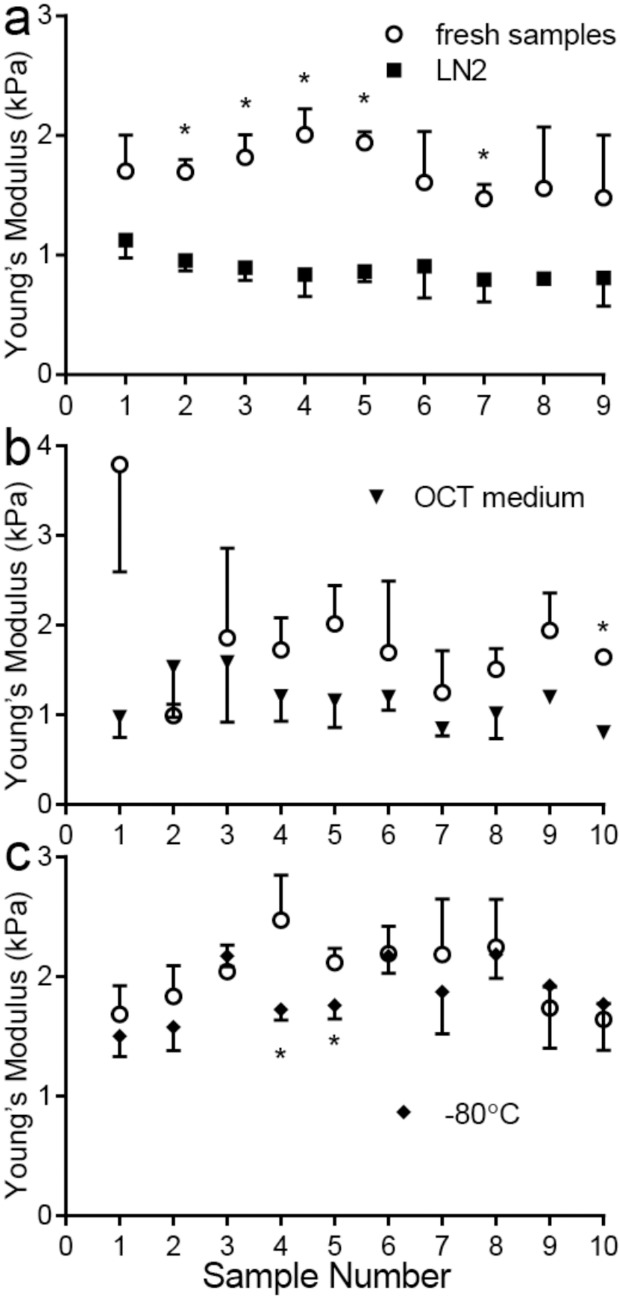
Mechanical properties of fresh vs. frozen tissue using micro-indentation.Fresh lung samples were tested using micro-indentation and then frozen using either (a) Liquid Nitrogen (LN2), (b) OCT medium with LN2, or (c) slowly frozen to -80°C, and subsequently re-tested. Samples marked with * are statistically significantly different after freezing, compared to the original fresh tissue specimen, (p<0.05) as found using a Student’s t-test. Error bars are shown in only one directly for clear visualization of the data.